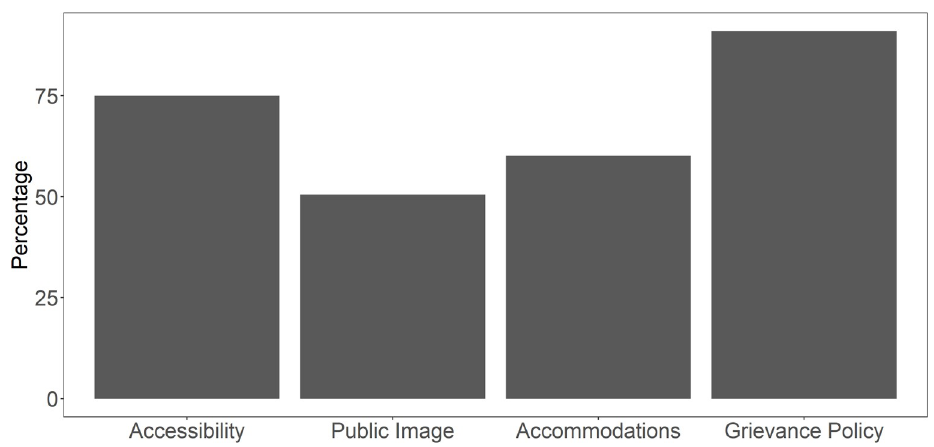
Fig 3. Percentage of points earned by institutions in each of the four scored